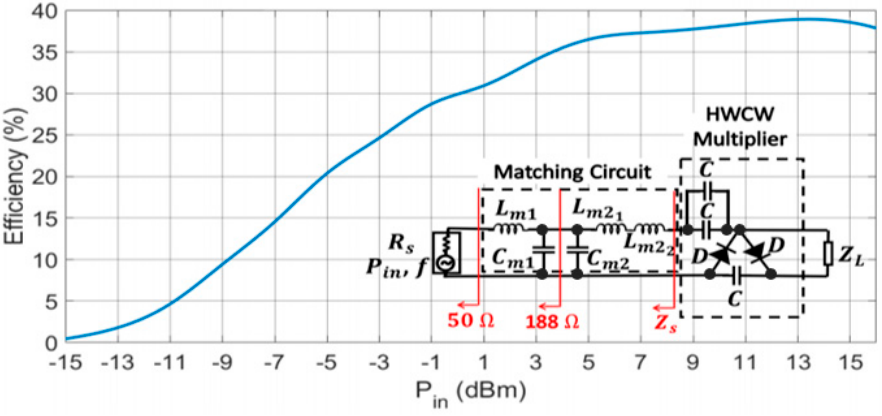
Figure 15. Measured efficiency as a function of the input power in the final circuit (at 870 MHz).